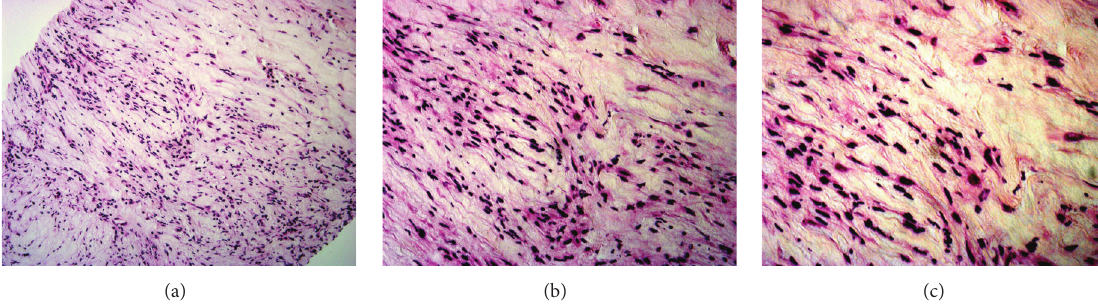
Figure 5: Retroperitoneal biopsy, H&E stain, × 200 (a), × 400 (b), and × 600 (c) showing fibrotic tissue and abundance of foamy macrophages.